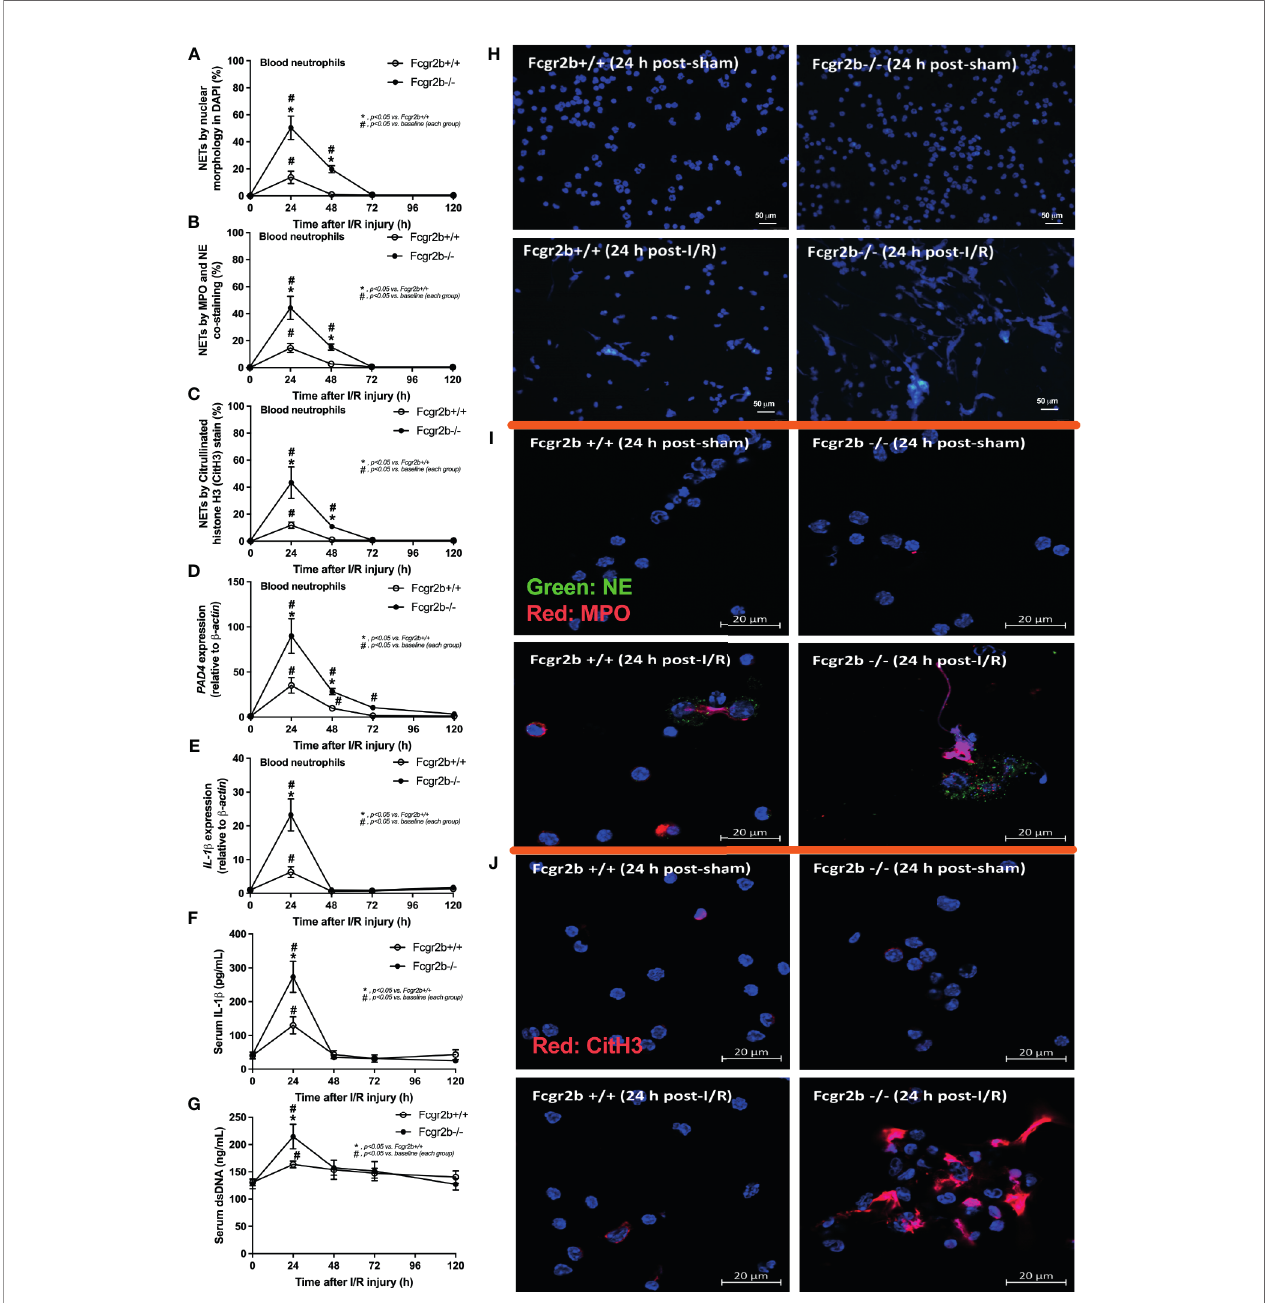
FIGURE 2 | Renal ischemia reperfusion injury (I/R) at 24 h induced more prominent neutrophil extracellular traps (NETs) in blood of lupus prone mice. Characteristics of NETs in peripheral blood neutrophils from Fcgr2b-/- or wild-type (Fcgr2b+/+) mice after renal ischemia reperfusion injury (I/R) as determined by the nuclear morphology by 4 ’ ,6-diamidino-2-phenylindole (DAPI) staining (blue color) (A) , co-staining of myeloperoxidases (MPO) and neutrophil elastase (NE) (B) , citrullinated histone H3 (CitH3) staining (C) with the representative pictures from peripheral blood neutrophils at 24 h post-I/R (or sham) from both mouse strains with DAPI staining (original magni fi cation 200x) (D) , and immuno fl uorescence of MPO/NE and CitH3 (original magni fi cation 630x) (E, F) are demonstrated. Additionally, the gene expression of PAD4 and IL-1 b (G, H) together with serum IL-1 b (I) and serum ds-DNA (J) are also demonstrated (n = 6 –